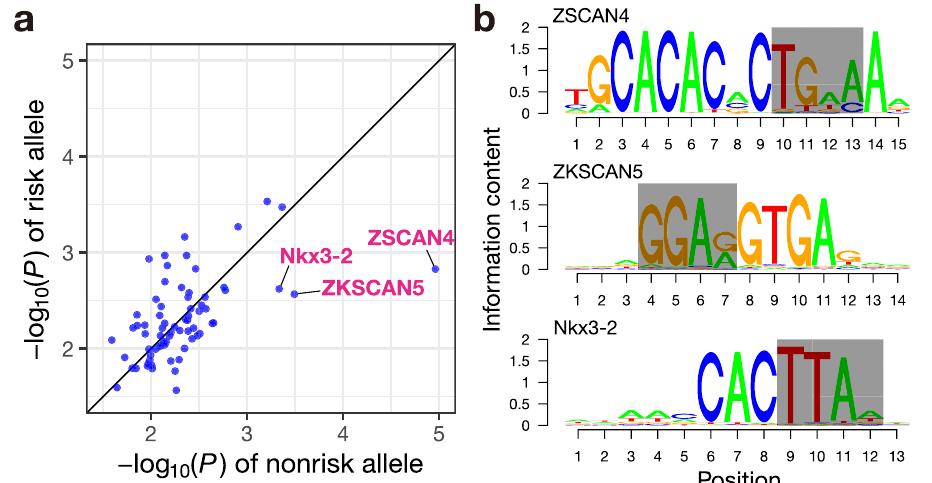
Fig. 3 | Disruption of transcription factor binding motifs by the deletion polymorphism rs3831846.a P valuesforsequence matchofthe riskalleleornon- risk allele sequence with TF binding motifs are shown. Each dot indicates a TF binding motif. A smaller P value indicates a more signi fi cant sequence match with the TF binding motif. Note that we use the P value provided by PWMScan as an